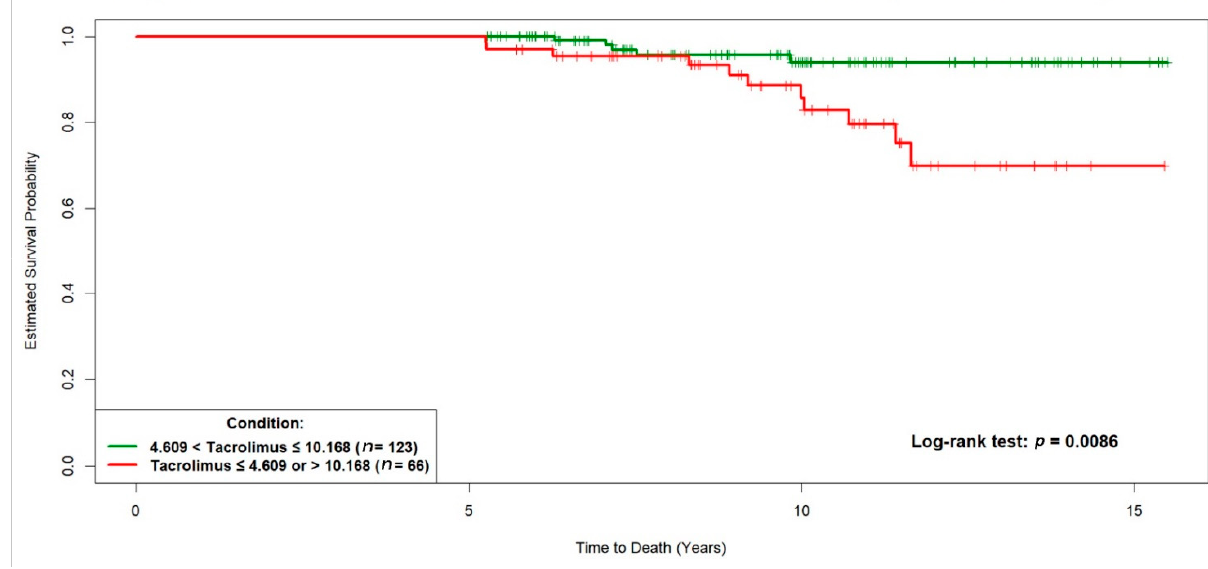
Figure 3. The p-spline plot for the nonlinear effect of the long-term tacrolimus blood trough levels on time to death. The tacrolimus blood trough level is shown on the X -axis, and the log( λ ), where λ is the hazard rate of time to death five years after liver transplantation, is shown on the Y -axis. In this p-spline plot, the intersection between the horizontal green line ( Y = 0) and the red curve yields the estimated optimal cut-off values for long-term tacrolimus blood trough levels at which the values of log( λ ) will not change (4.609 ng/mL and 10.168 ng/mL). When the level is ≤ 4.609 ng/mL or >10.168 ng/mL, the value of log( λ ) increases, indicating an increasing λ . When the level is >4.609 ng/mL and ≤ 10.168 ng/mL, the value of log( λ ) decreases, indicating a decreasing λ . The vertical bars above the X -axis represent the patients’ actual mean tacroli- mus blood trough levels obtained at the three follow-up visits during the fifth year after LT.